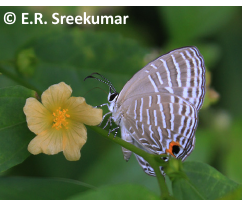
Image 50. Restricted Demon Notocrypta curvifascia